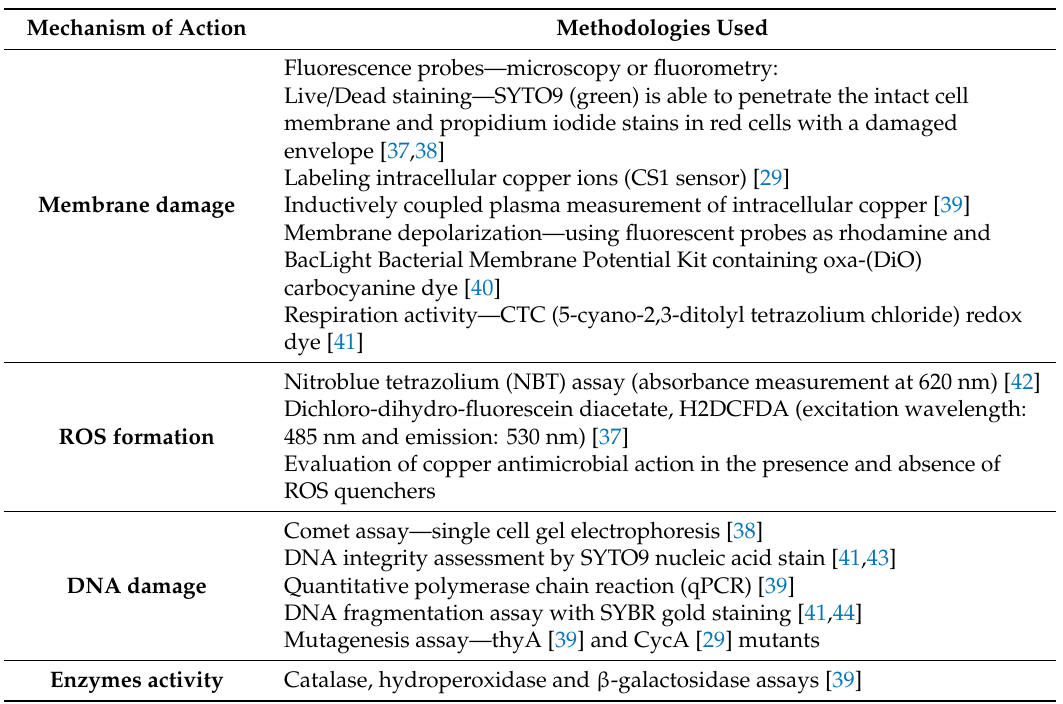
Table 1. Examples of methodology applied to assess the mode of interaction of copper with microbial